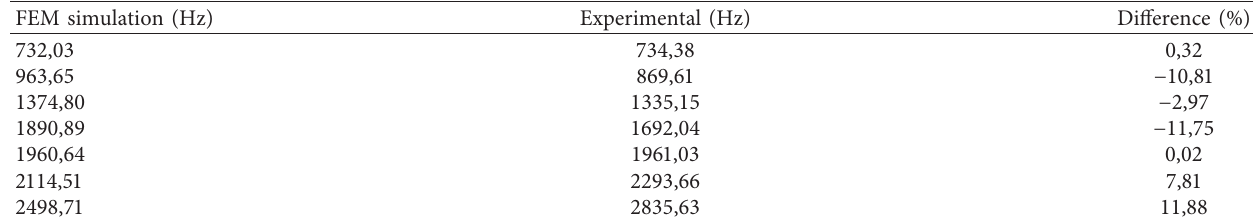
Table 10: Comparison of numerical and experimental frequencies (Case 2).